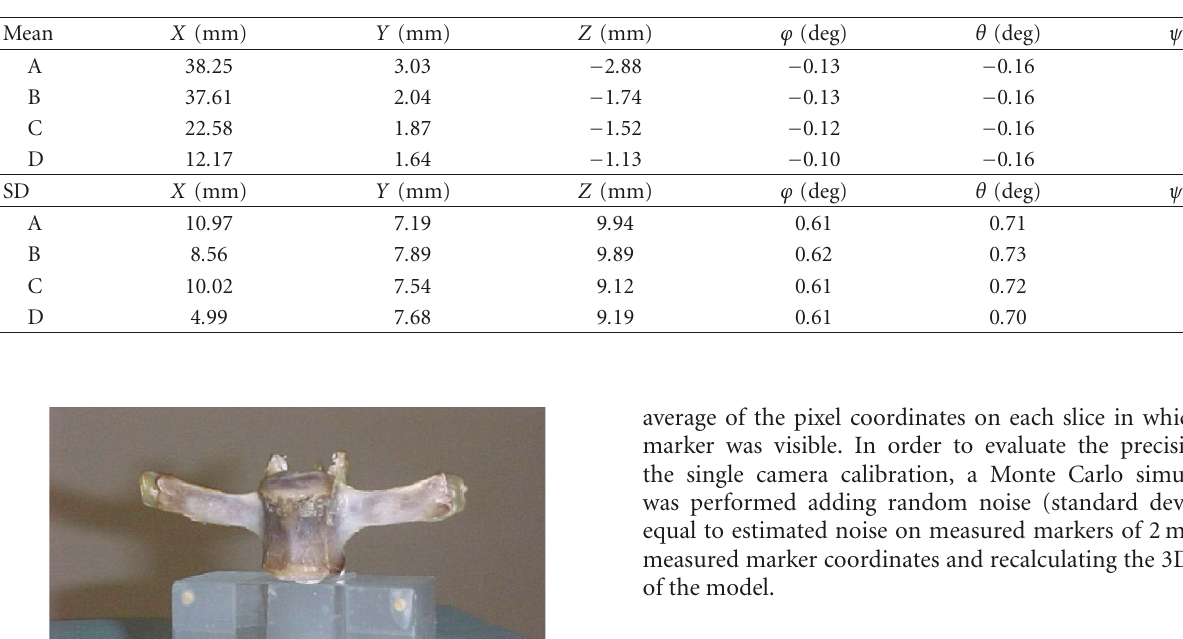
Table 2: Means and standard deviations (SD) of the errors in computing the 6 parameters of the 3D vertebral pose with respect to the reference value obtained via metallic marker camera calibration. The letters refer to the type of correction performed (see text).